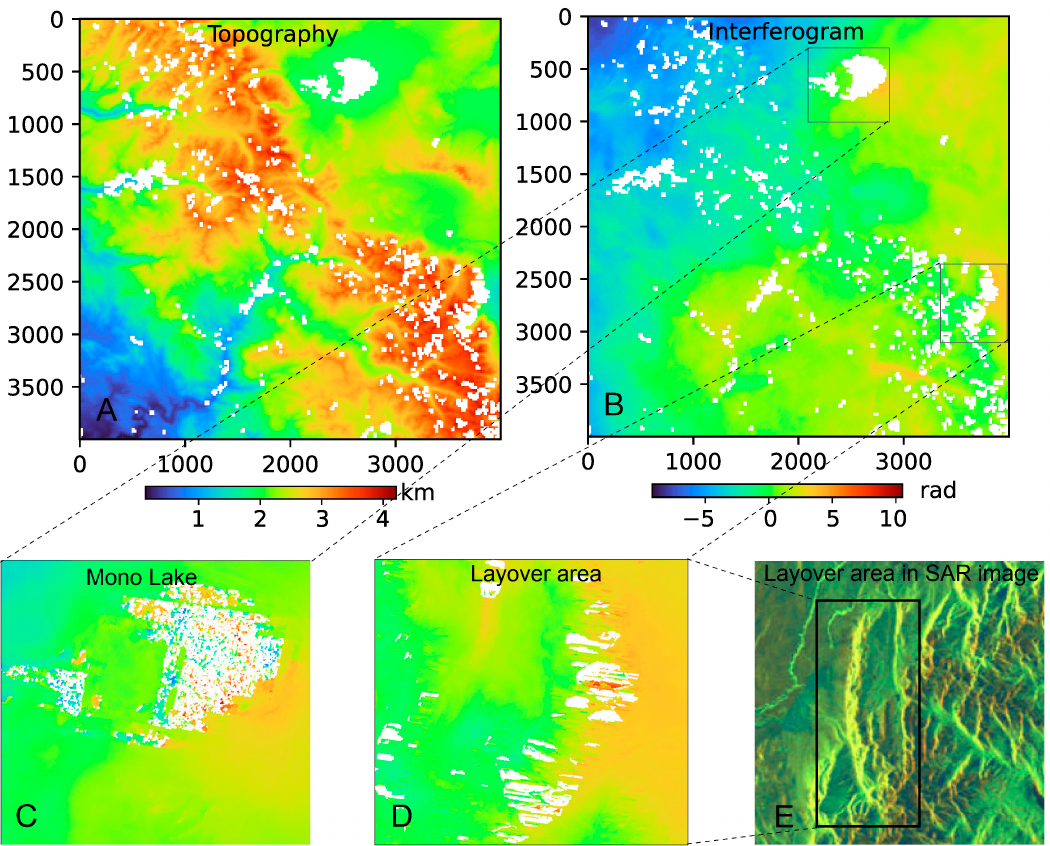
Figure 6. ( A ) The topography of the Sierra Nevada mountains; ( B ) the original interferogram; ( C ) the Interferogram of the Mono Lake area (Despite the mask processing, a large number of noise signals remain in this area); ( D ) the layover area in the interferogram; ( E ) the layover area in SAR image.